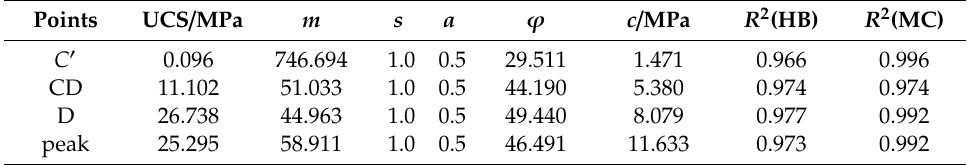
Table 2. Stress parameters of the sandstone using the linear Mohr–Coulomb and non-linear